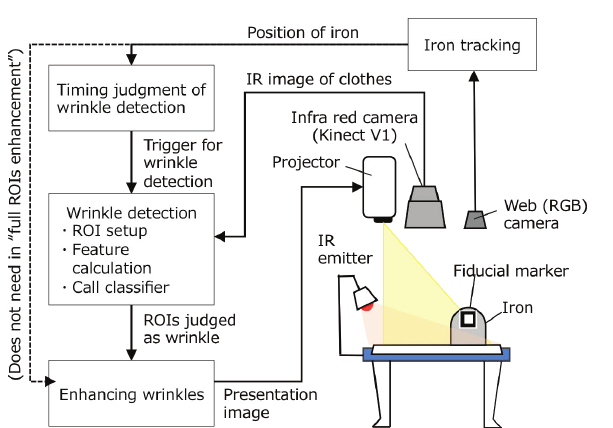
Figure 1. The con(cid:12)guration and major components of the proposed